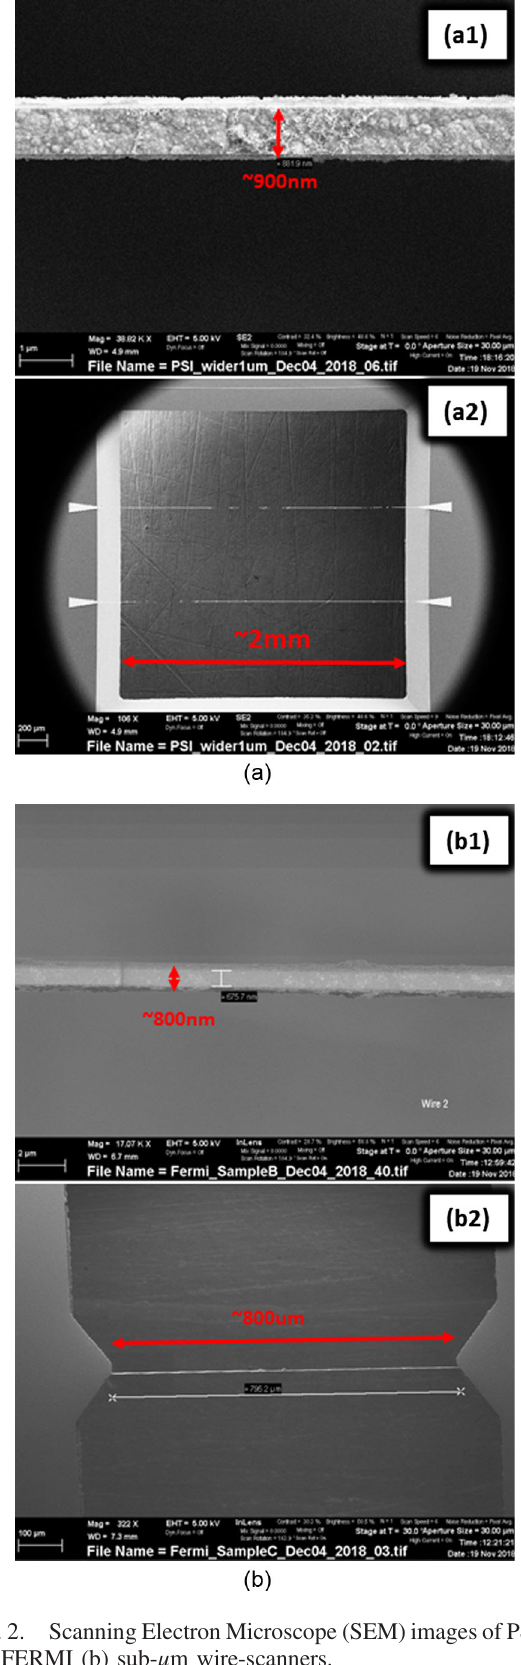
FIG. 2. Scanning Electron Microscope (SEM) images of PSI (a) and FERMI (b) sub- μ m